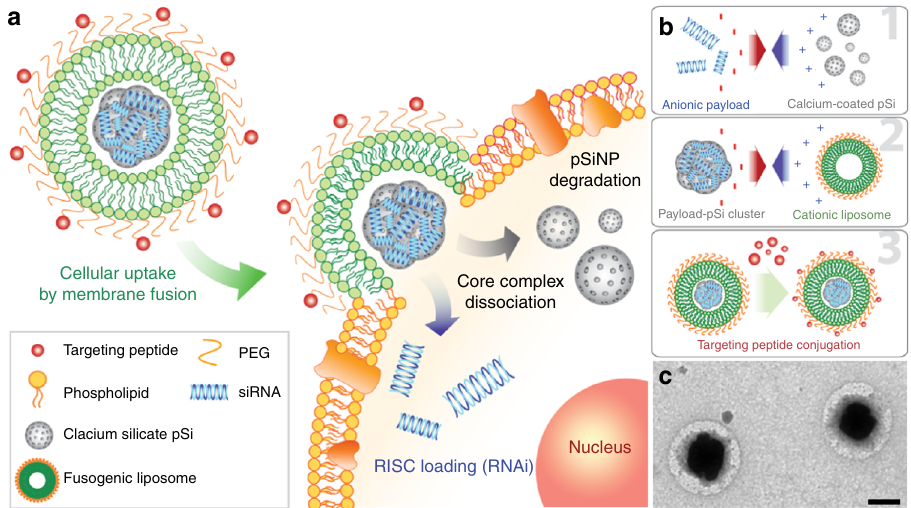
Fig. 1 Fusogenic pSi nanoparticle system (F-pSi). a Schematic showing mode of action of the fusogenic pSiNP. b Schematic showing nanoparticle synthesis, including (1) siRNA loading into the porous silicon nanoparticles and sealing by precipitation of calcium silicate; (2) coating of the nanoparticle clusters with cationic liposome; and (3) conjugation of targeting peptides to the liposomal exterior. c TEM image of fi nal F-pSi constructs, showing cloudy liposomal coatings around dark and dense porous silicon-based cores. Imaged using JEOL 1200 EX TEM. Negative staining by 2% phosphotungstic acid. Scale bar indicates 200